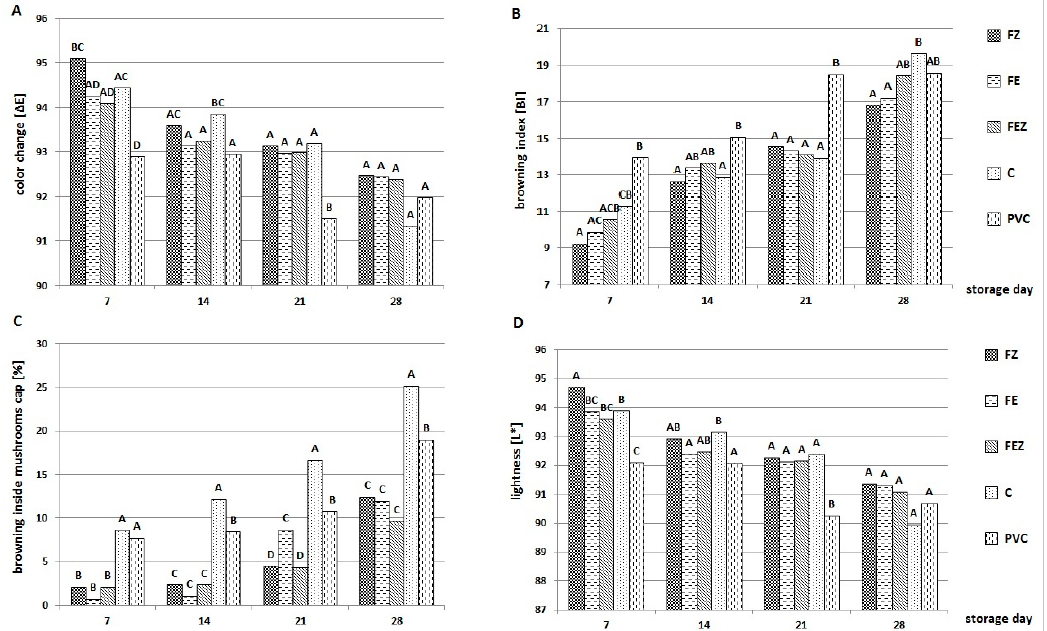
Figure 1. Color changes on the surface of the caps: color change ( A ), browning index ( B ), lightness ( D ) and browning degree inside mushroom caps ( C ) in different active packaging with zeolite (FZ), a ҫ ai extract (FE), a ҫ ai extract + zeolite (FEZ) packed in MAP, without active packaging in MAP ( C ) and wrapped in polyvinyl chloride foil (PVC) measured on each storage day. A, B, C—letters mark differences between packaging on the same storage day.